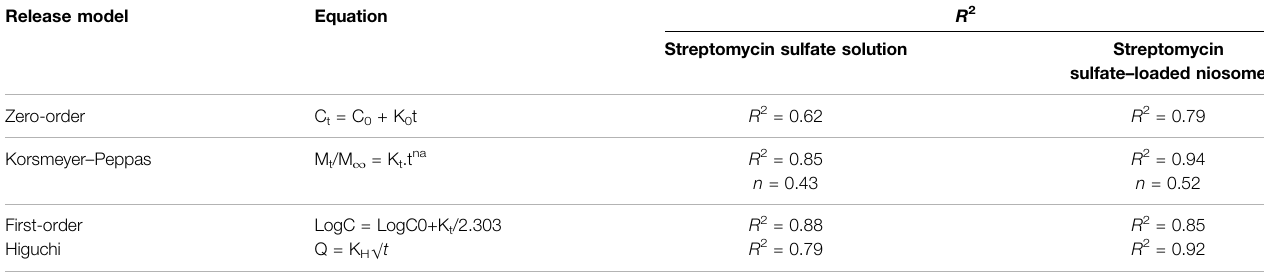
TABLE 4 | Release kinetic models and the parameters obtained for niosomal formulations.